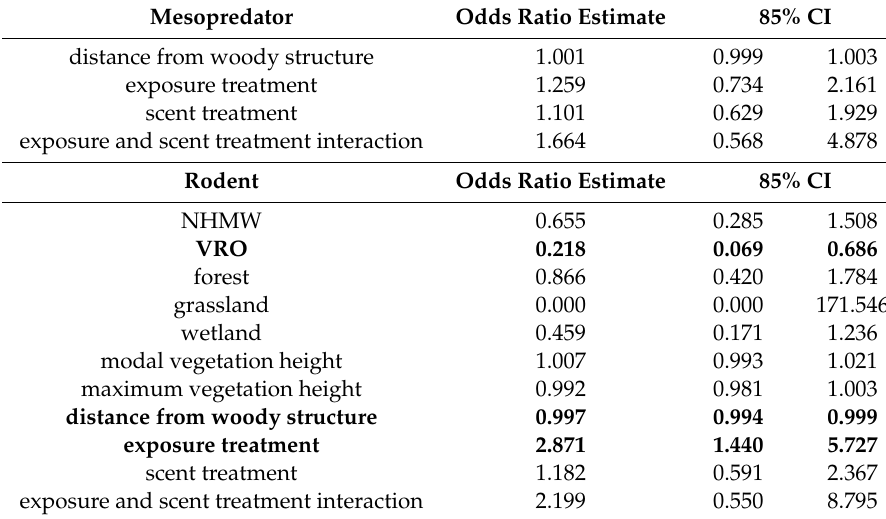
Bolded values indicate confidence limits of odds ratio estimates excluding 1.